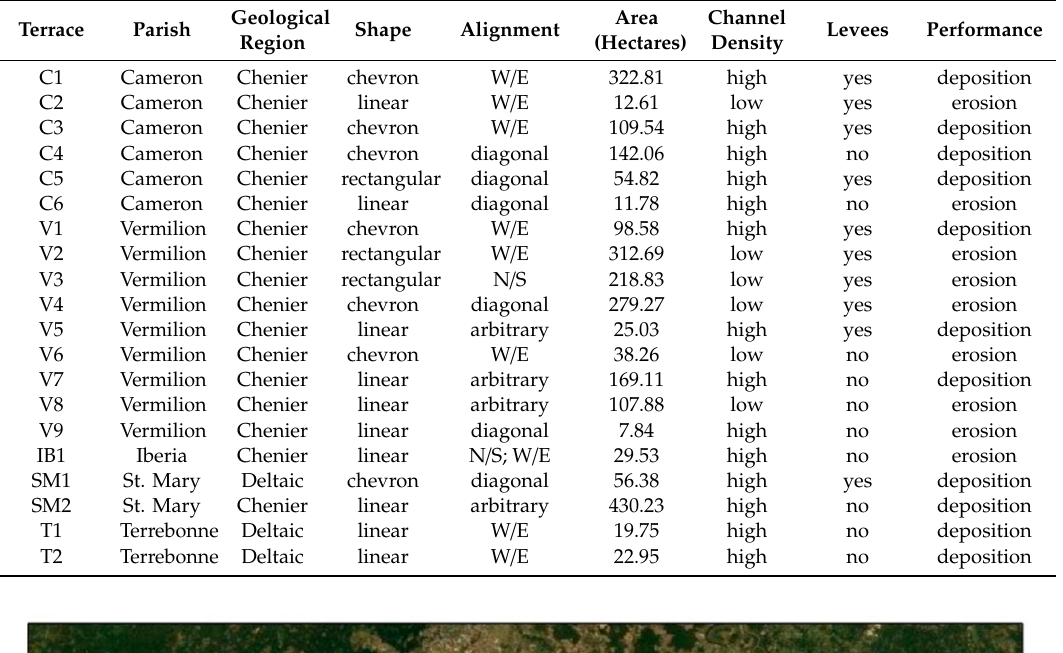
Table 3. Marsh terraces fields of study design factors and performance. Alignment definitions: west to east terrace alignment (W / E), north to south terrace alignment (N / S), arbitrary refers to a terrace alignment following di ff erent directions within a terrace field of study. Channel density definitions: high refers to channels surrounding or connecting with the terrace field of study; low refers to either few channels surrounding or connecting with the terrace field of study or presence of channels not connected with the terrace field of study blocked by levees or dikes. Performance refers to either predominant deposition or erosion in a field of study.